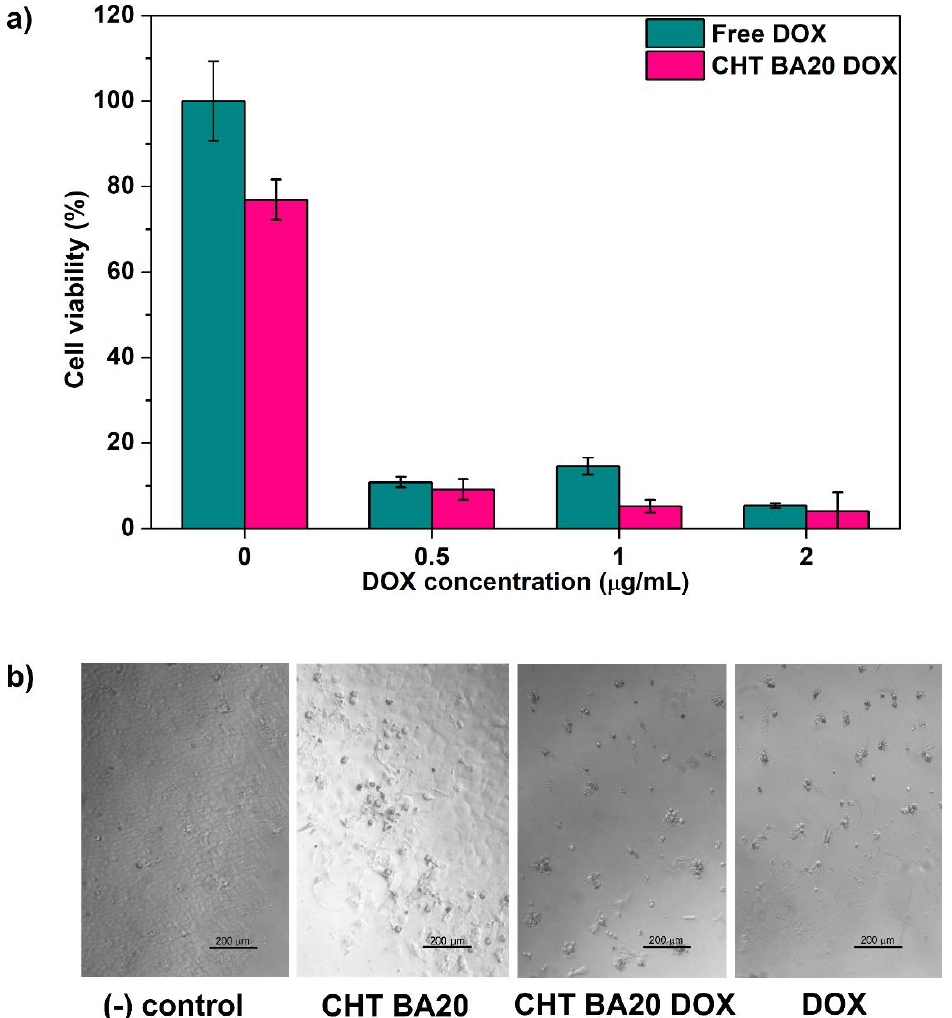
Figure 6. ( a ) Cell viability assay of U2OS cells cultured with DOX-encapsulated chitosan-boric acid scaffolds for 3 days; ( b ) Optical micrographs of U2OS after 3 days of incubation (scale bar: 200 µm).